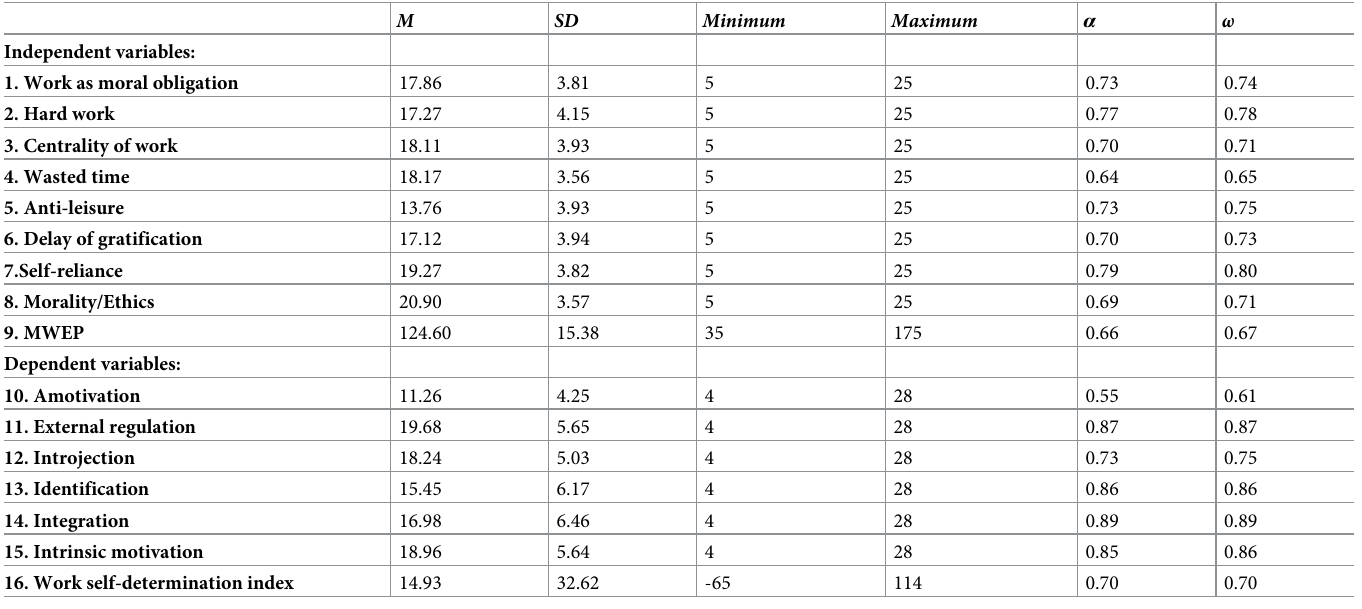
Table 1. Descriptive statistics and reliability coefficients of work ethic dimensions (MWEP) and components of motivation to work (WEIMS). M SD Minimum Maximum α